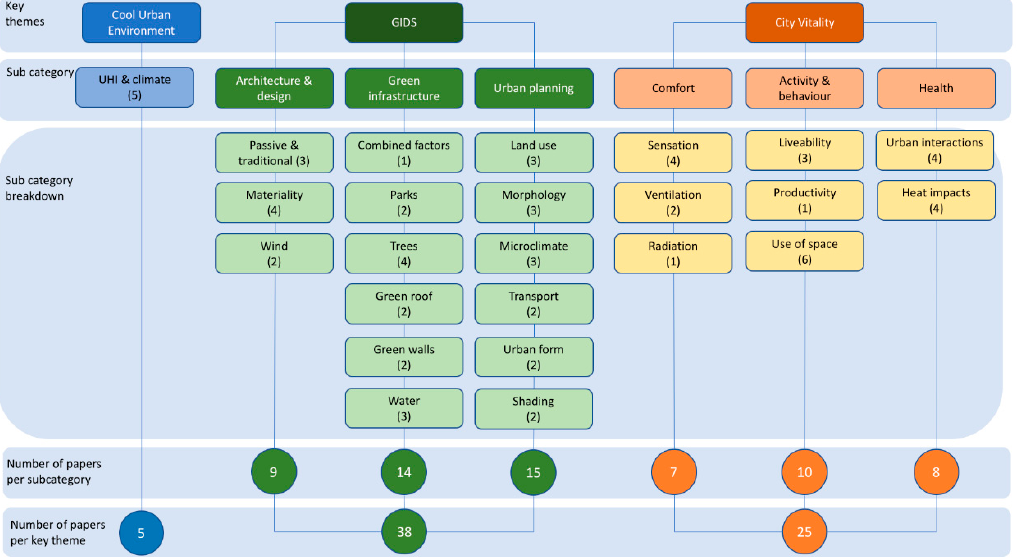
Figure 2. SLR abstract review: number of papers included across key themes and sub-categories.